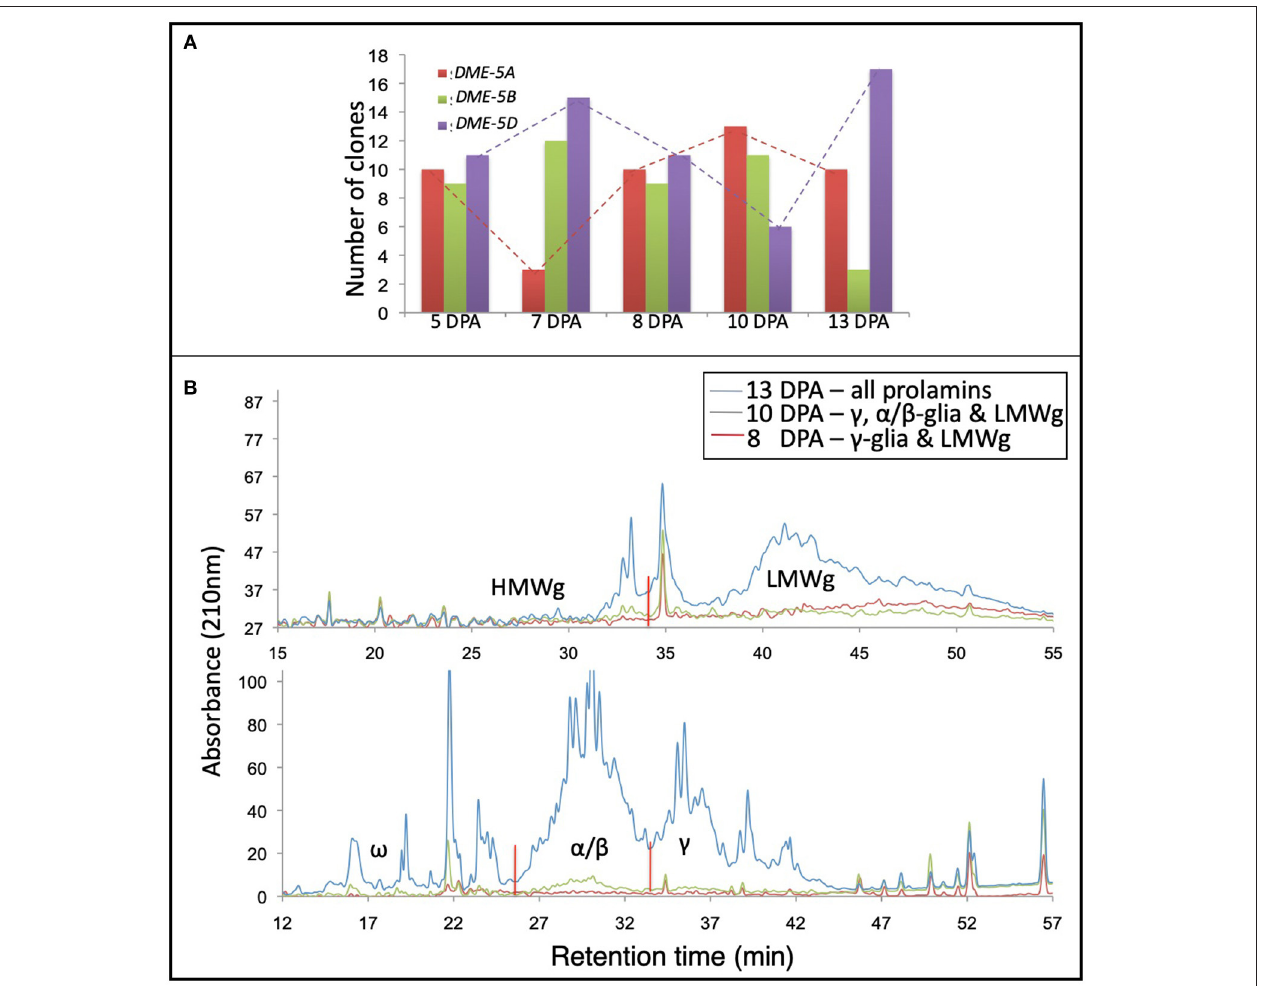
FIGURE 3 | Coordinate expression of DEMETER and gluten proteins in the wheat grain. Picture showing the expression patterns of the wheat DEMETER homoeologues studied in developing endosperm at 5, 7, 8, 10, and 13 days post-anthesis (DPA) via PCR-cloning and DNA sequencing. (A) High-performance liquid chromatography of gliadins and glutenins from developing wheat grains at 8, 10, and 13 DPA. (B) Notice differential accumulation of different gliadins and glutenins in developing grains and the transcript abundance of different wheat DEMETER